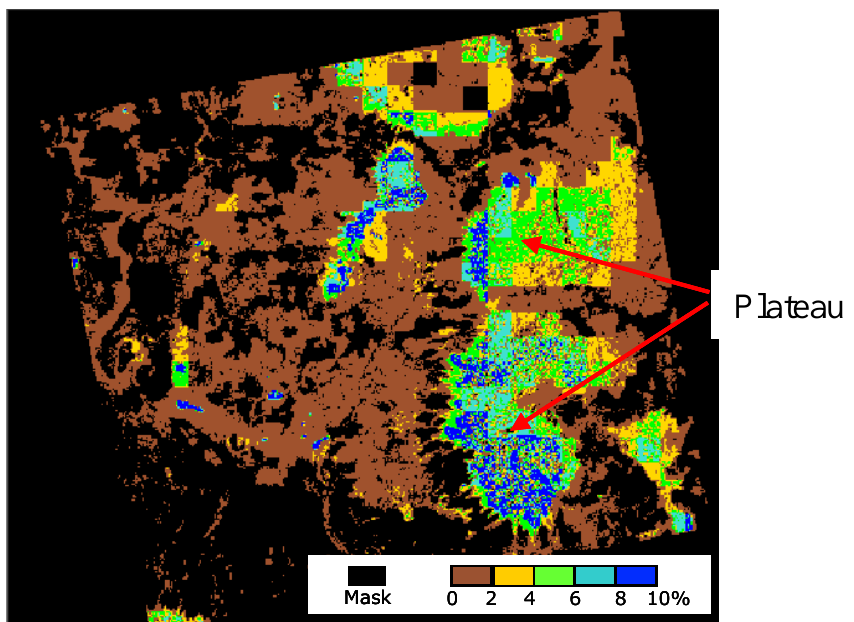
Figure 8. Soil moisture mapping over Banizoumbou on 29 May by method 1 (cells of 500 × 500 pixels). The image covers 10 km × 10